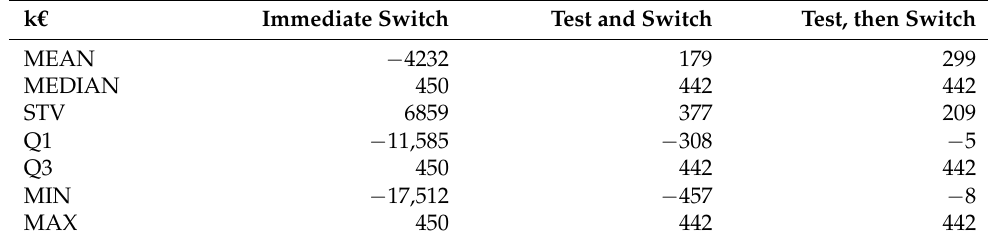
Table 2. Results of the risk-assessment tool application on the use-case. k€ Immediate Switch Test and Switch Test, then Switch